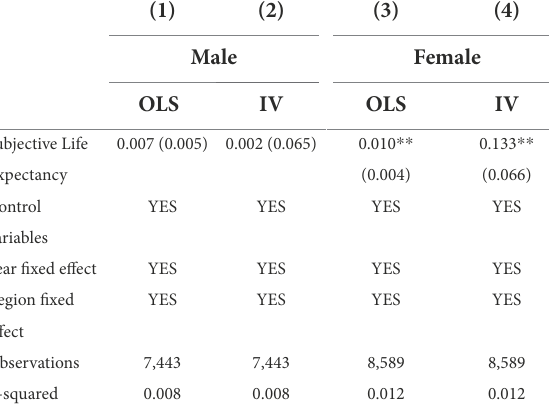
TABLE 4 Gender heterogeneity.